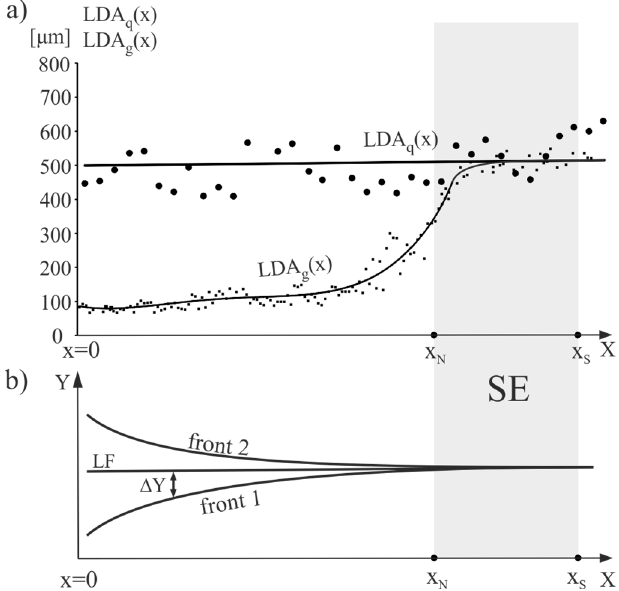
Figure 5. ( a ) The LDA g (x) and LDA q (x) relations; ( b ) hypothetical shape of crystallization fronts. LF—linear front perpendicular to the withdrawal direction.